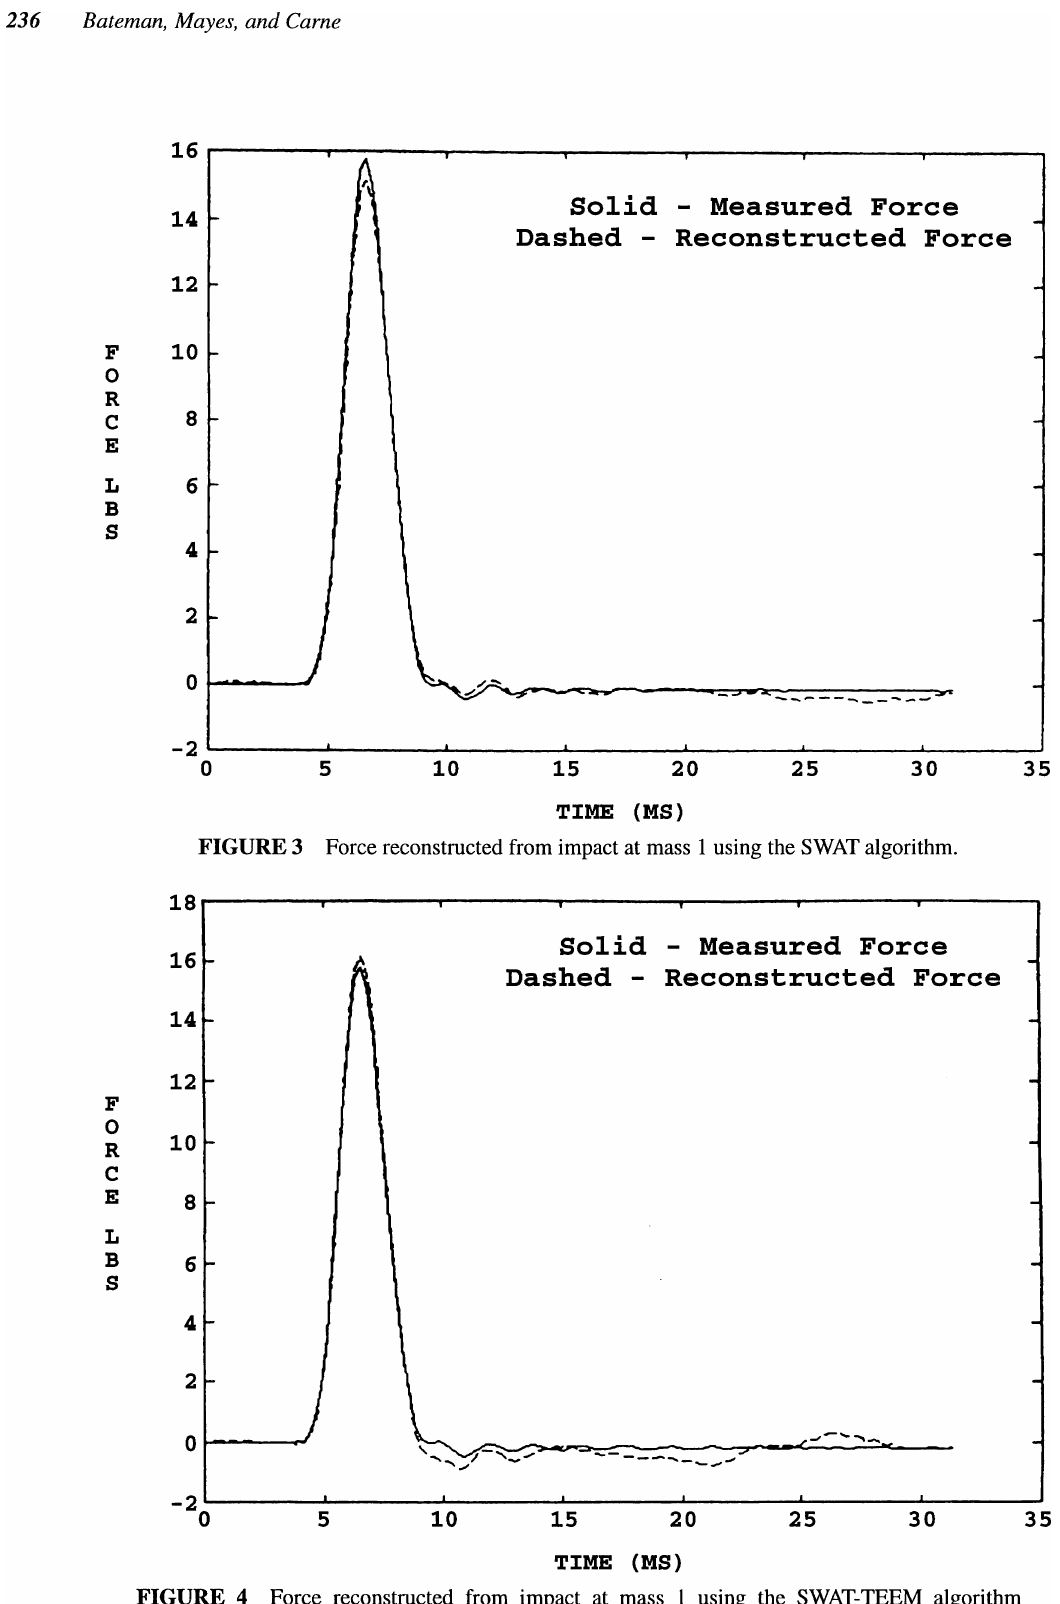
FIGURE 4 Force reconstructed from impact at mass using the SWAT-TEEM algorithm (weights averaged from impacts at mass